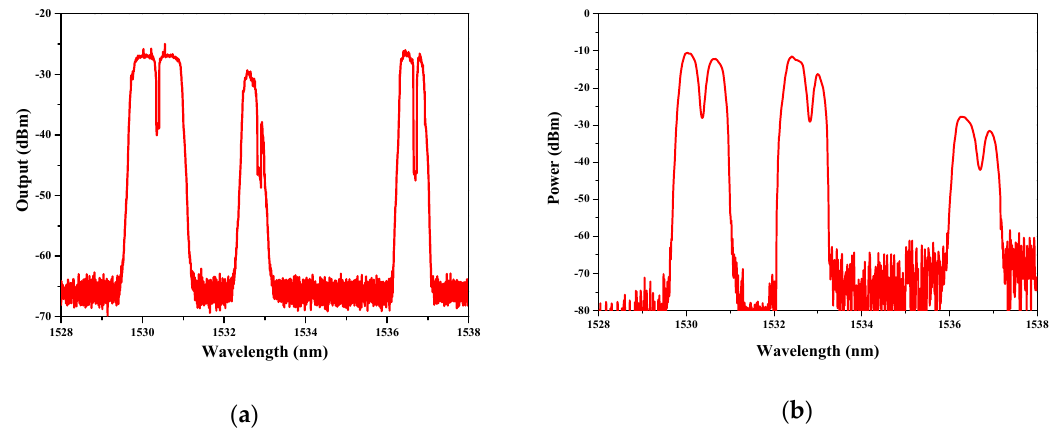
Figure 11. ( a ) Experimental absorption spectra with 10,000 ppmv C 2 H 2 ; ( b ) calculated absorption spectra with normalized intensity.